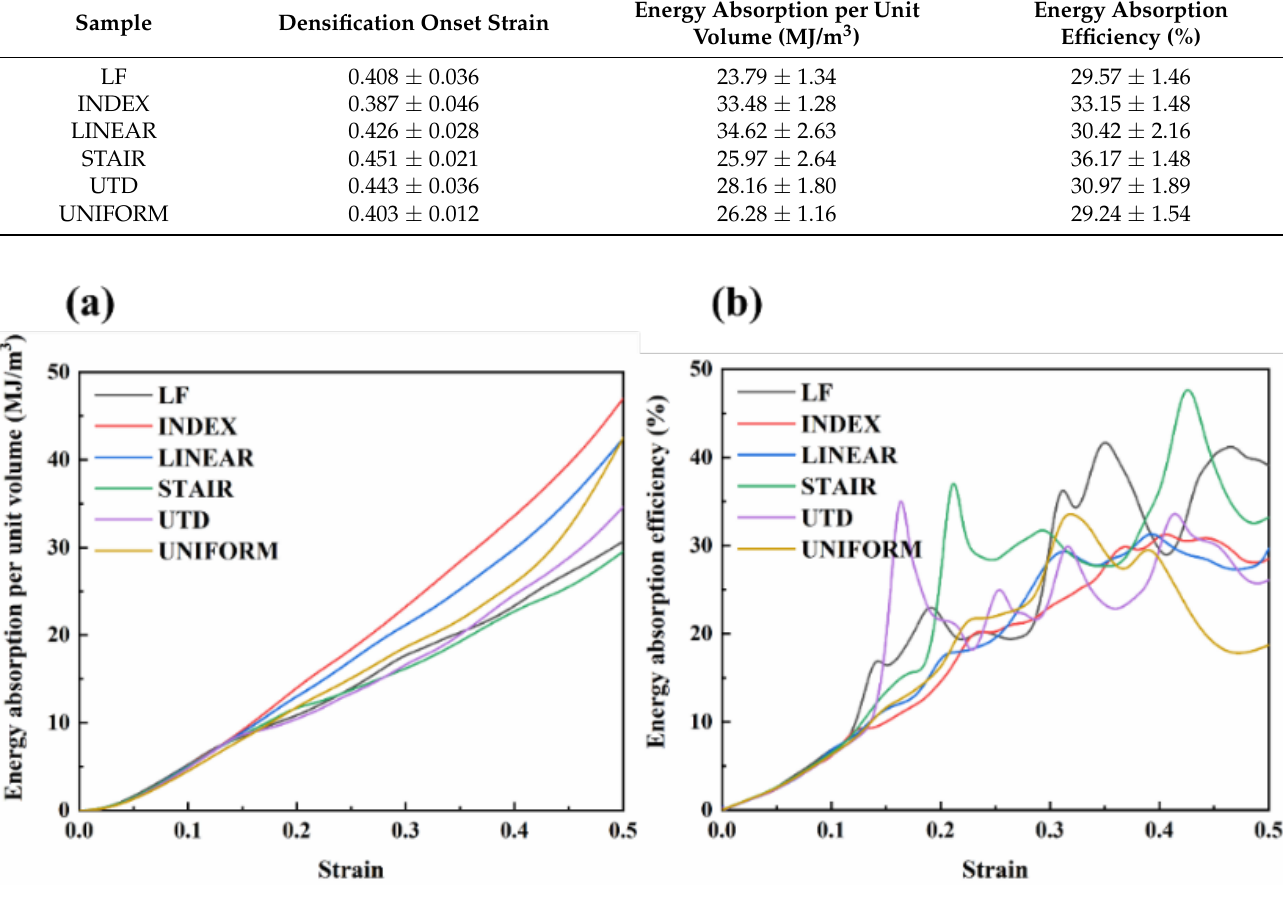
Figure 5. Energy absorption properties of different lattice structures; ( a ) energy absorption per unit volume; ( b ) energy absorption efficiency. Table 4. Densification onset strain and energy absorption properties of different lattice structures.